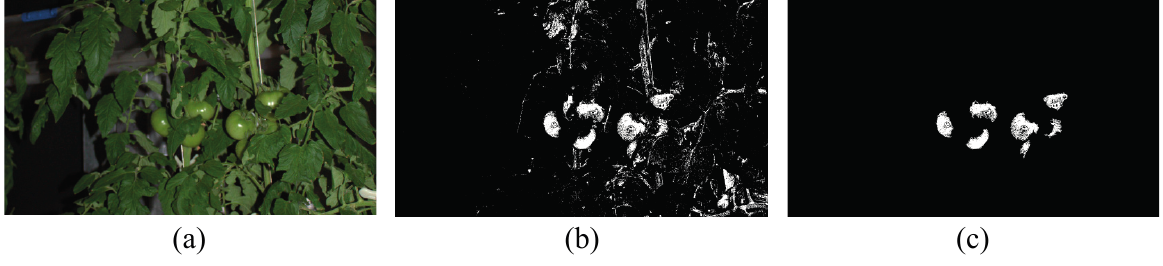
Figure 8. Example of false positive elimination by blob-based segmentation. ( a ) Original image (the middle section of one of the test images); ( b ) Result of pixel-based segmentation, where a pixel color of white belongs to the fruit class; ( c ) Result of false positive elimination by blob-based